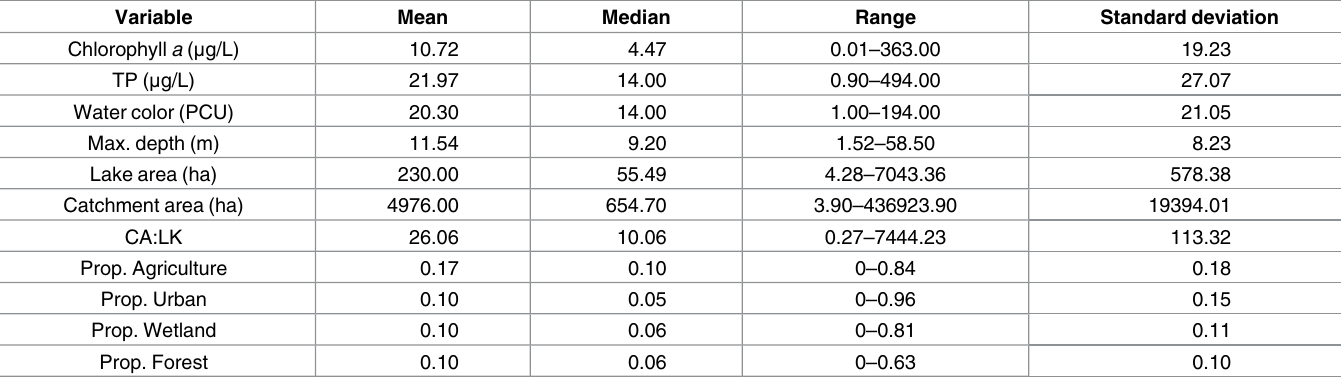
Table 1. Summary statistics of the full lake